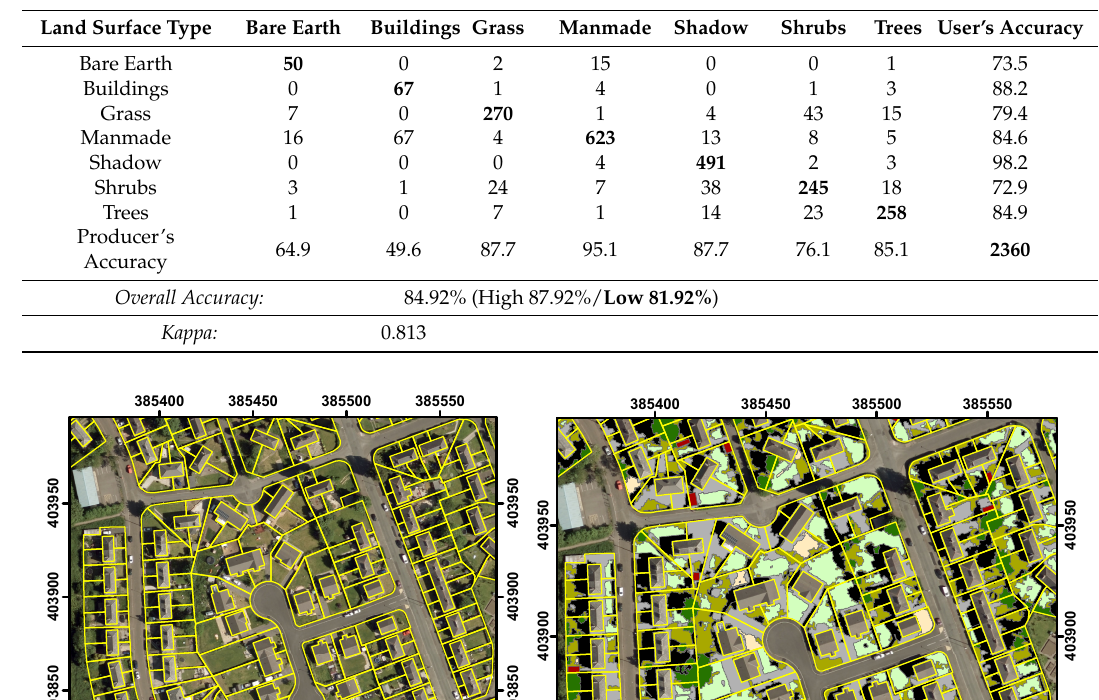
Table 7. Confusion Matrix for 2015 image classification.